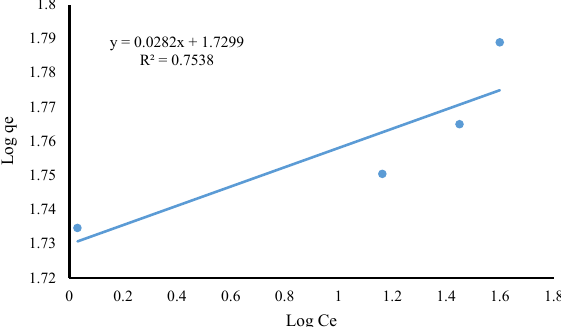
y = 0.0282x + 1.7299 R² = 0.7538